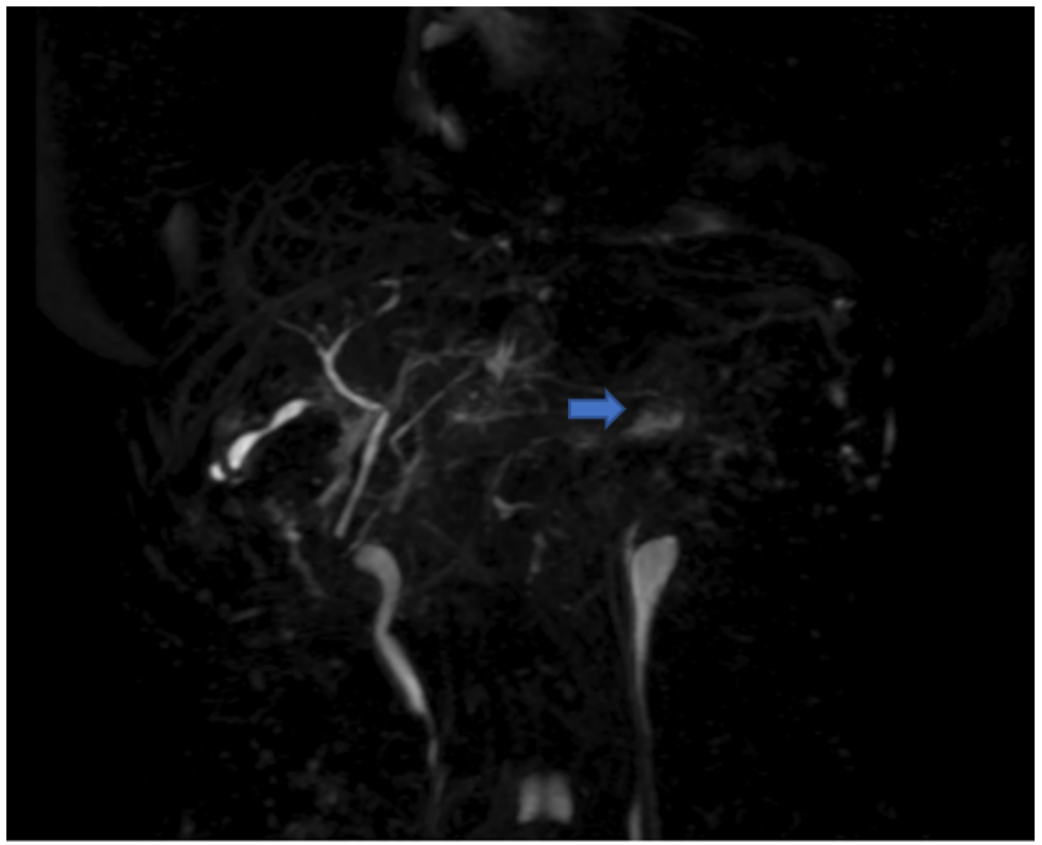
Figure 3. Magnetic resonance cholangiopancreatography showing poor uptake of the contrast medium, especially on the left lobe of the liver (blue arrow).